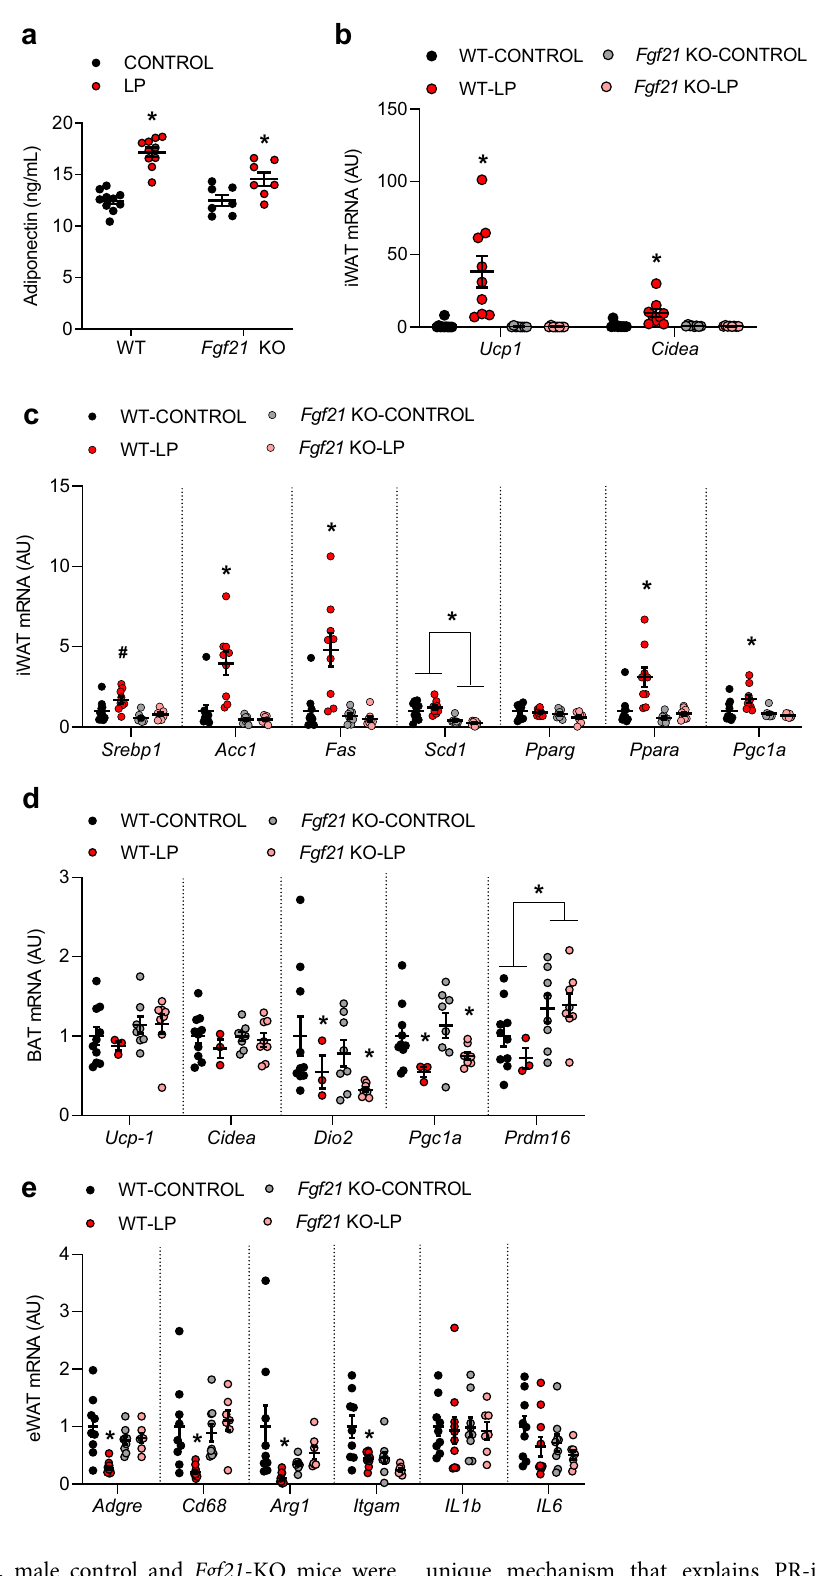
unique mechanism that explains PR-induced longevity in a mammalian model. The differential effects of PR on lifespan in the WT and